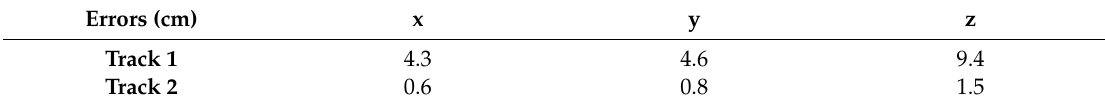
Table 3. Maximum errors of the CDGPS